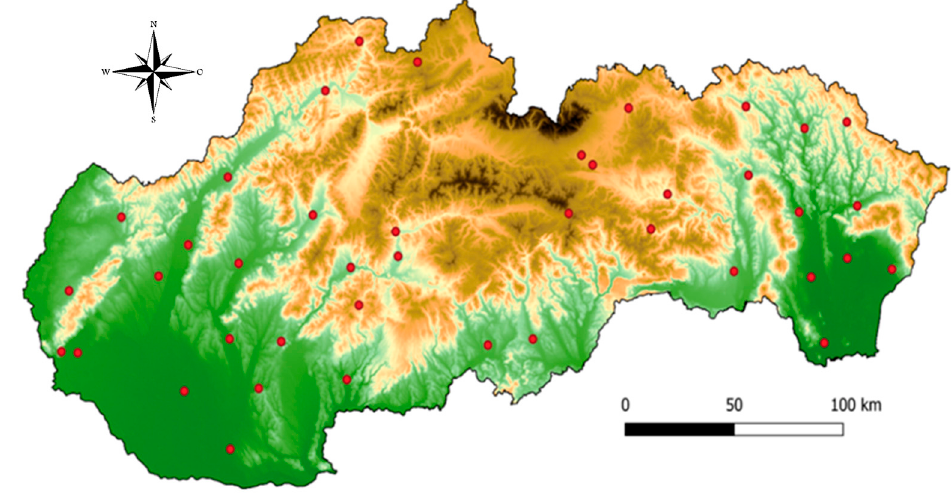
Figure 2. Network of meteorological stations in Slovakia.